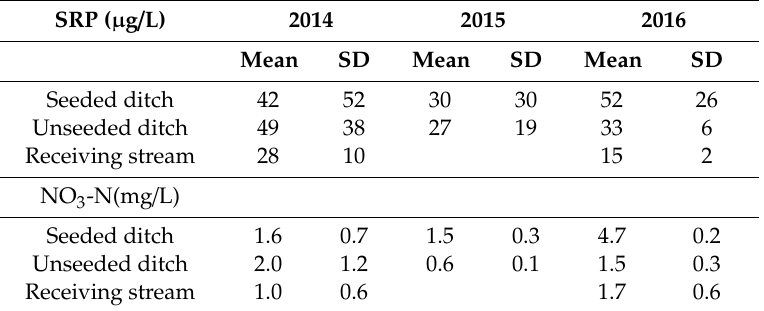
Table 2. Mean and standard deviation of NO 3 -N and SRP concentrations in ditch and receiving stream